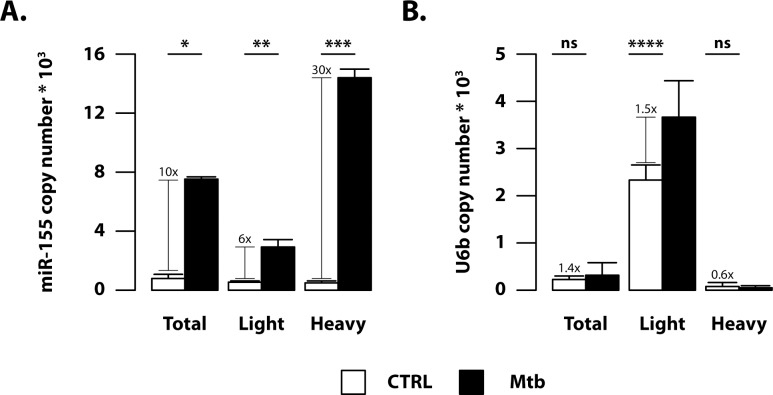
Mtb-induced miR-155 preferentially combines with polysome-associated mRNAs.Total RNA (Total), low occupancy (Light) and high occupancy (Heavy) polysome-associated mRNAs were extracted from untreated DC (CTRL) or DC infected for 16 hours with Mtb. (A) MiR-155 and (B) U6b copy number were determined by digital PCR. Data are represented as the mean copy number per sample ± standard error of the mean of three independent experiments.(*p = 0.00003; **p = 0.0008; ***p = 0.00009; ****p = 0.04).